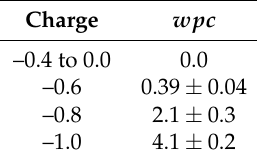
Table 2. Presence of water bridges in networks; wpc - water bridges related to number of physical